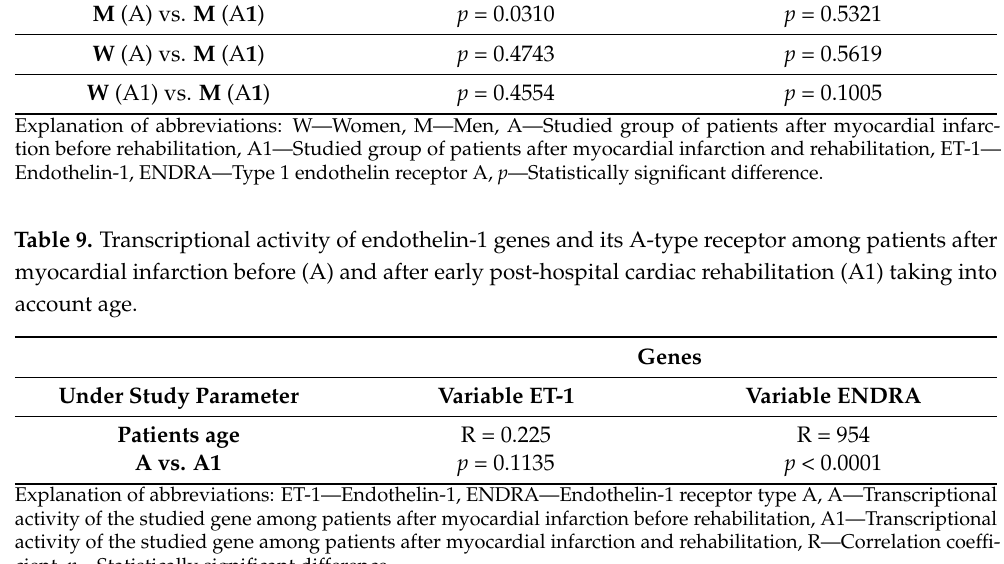
Table 8. Transcriptional activity of endothelin-1 genes and type 1 endothelin receptor in the stud- ied group of patients after myocardial infarction before (A) and after early post-hospital cardiac rehabilitation (A1) taking into account the sex of the respondents. Variable Genes ET-1 ENDRA